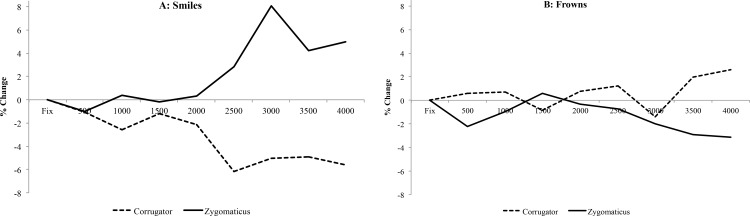
Analysis within emotion.Panel A shows analysis of smiles. This shows a difference score between consistent–inconsistent activity within each muscle to smiles. Panel B shows the same calculation, but between consistent–inconsistent frowns.